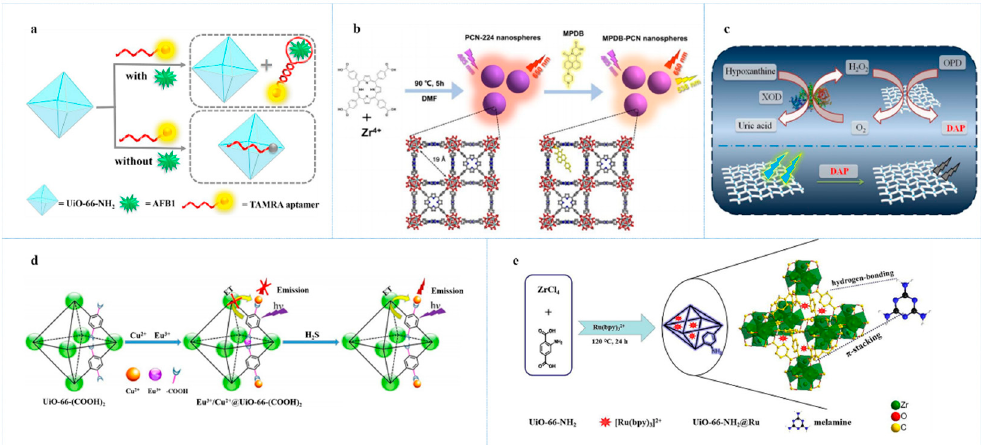
Figure 4. ( a ) Schematic illustration of the fluorescent aptasensor for AFB 1 detection base on UiO-66-NH 2 , reprinted with modifications from Jia et al. [76]; ( b ) schematic representation of solvothermal synthesis of PCN-224 nanospheres and post-synthetic modification fabrication process of MPDB-PCN nanospheres, reprinted with modifications from Guo et al. [77]; ( c ) schematic illustration for the principle of the biosensor based on NH 2 -Cu-MOF nanosheet, reprinted with modifications from Hu et al. [80]; ( d ) schematic illustration of the fluorescence detection mechanism based on Eu 3+ /Cu 2+ @UiO-66-(COOH) 2 , reprinted with modifications from Zhang et al. [82]; ( e ) schematic illustration of the preparation process and the ratiometric fluorescence detection of melamine based on UiO-66-NH 2 @Ru Probe, reprinted with modifications from Lin et al. [89].